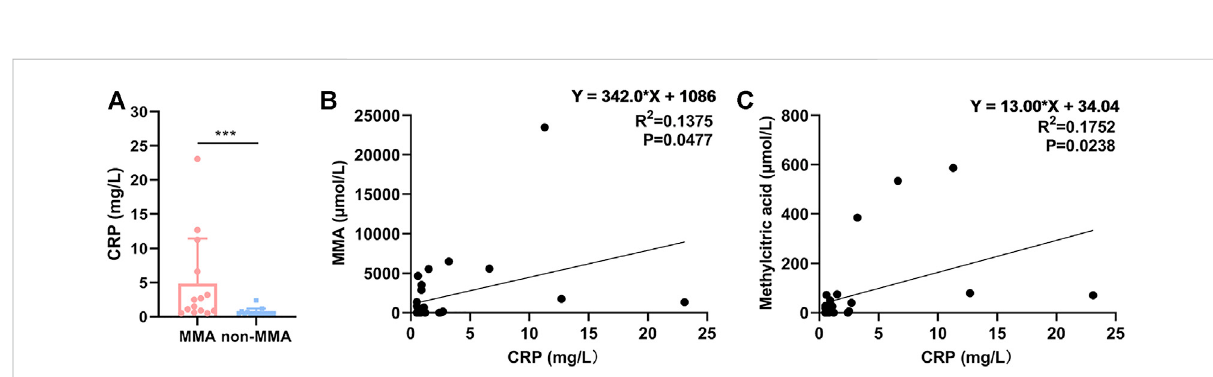
FIGURE 6 CRP was positively correlated with MMA. (A) Levels of CRP in serum of 14 MMA patients and 15 non-MMA (uninfected) patients. (B) Correlation analysis of serum CRP and MMA. (C) Correlation analysis of serum CRP and methylcitric